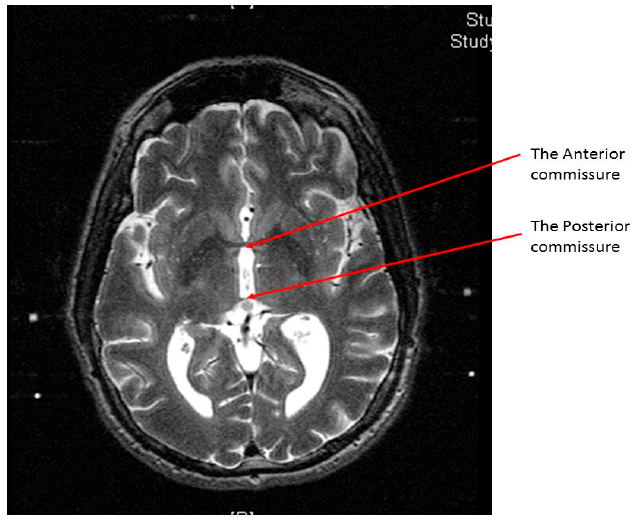
Figure 2. An axial T2 weighted magnetic resonance image showing the anterior commissure and the posterior commissure at the same cut.